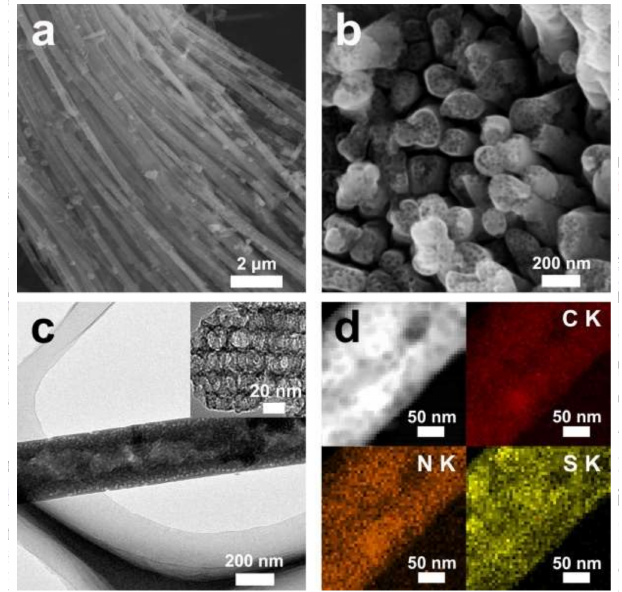
Figure 2. ( a , b ) Side-view and top-view SEM images of OMPW, ( c ) TEM image of OMPW, and ( d ) dark-field TEM image of sulfer/OMPW (S/OMPW) composite and corresponding elemental maps of carbon (red), nitrogen (orange), and sulfur